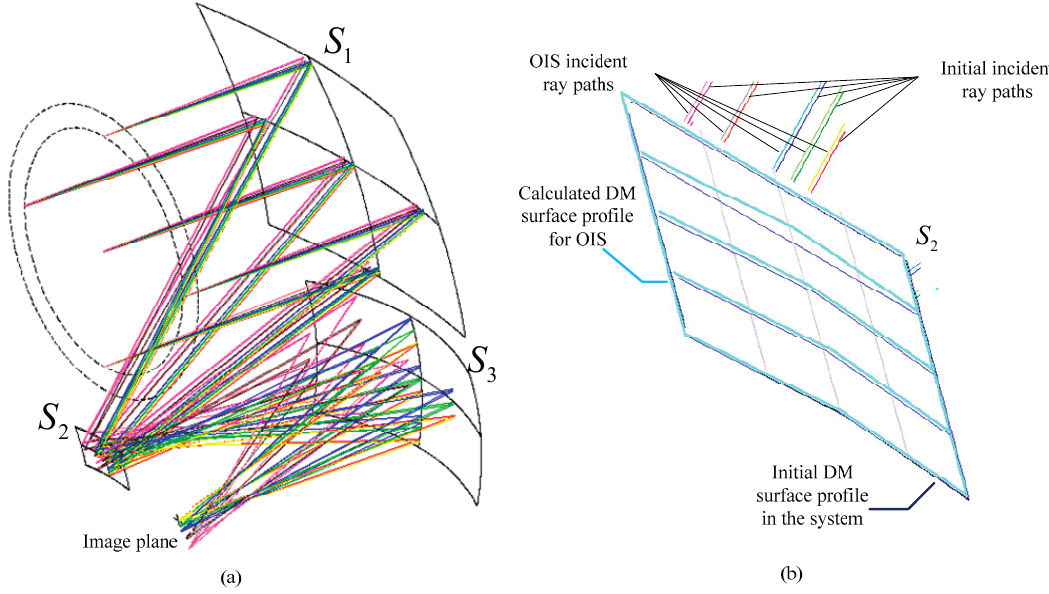
Figure 4. ( a ) Ray tracing paths overlay the configurations for the initial system and the one DM OIS system with the calculated surface profile; and ( b ) an enlarged drawing showing the initial DM surface profile in the system as dark blue segments, and the calculated DM surface profile for OIS as the light blue segments, indicating the initial incident and the OIS incident ray